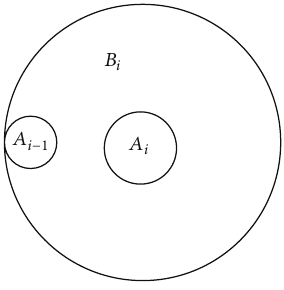
Figure 6: Attraction